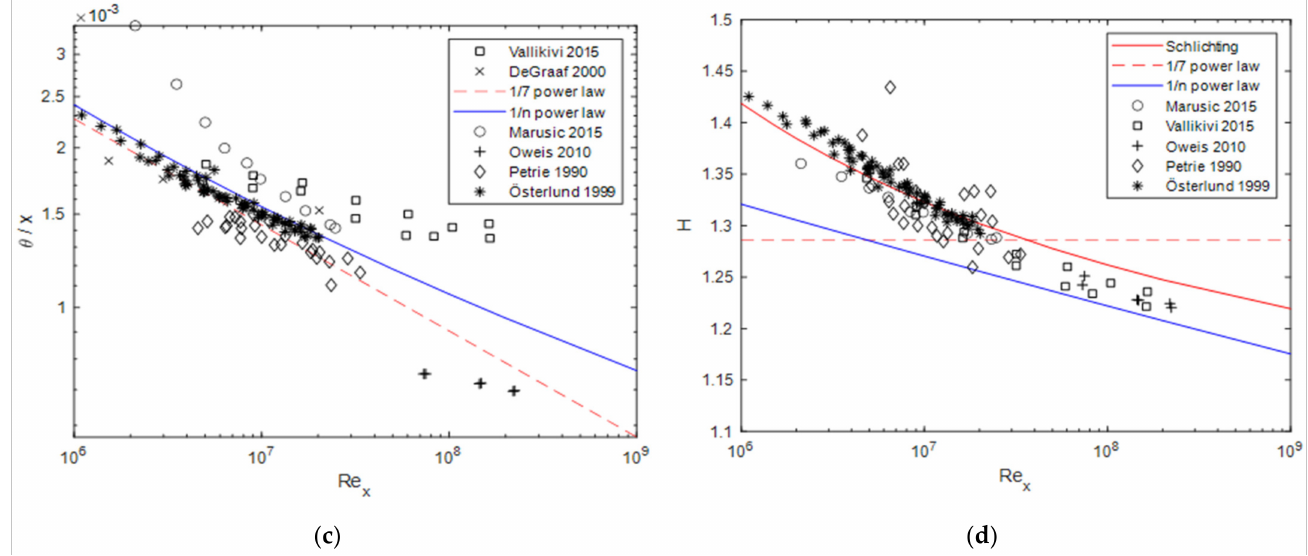
Figure 3. Boundary layer thicknesses and form parameter compared to the data given by DeGraaff and Eaton [15], Marusic et al. [13], Oweis et al. [14], Österlund [10], Petrie et al. [16], Schlichting and Gersten [17], and Vallikivi et al. [11]: ( a ) boundary layer thickness; ( b ) displacement thickness; ( c ) momentum thickness; ( d ) form parameter, with Schlichtings formula H = 1